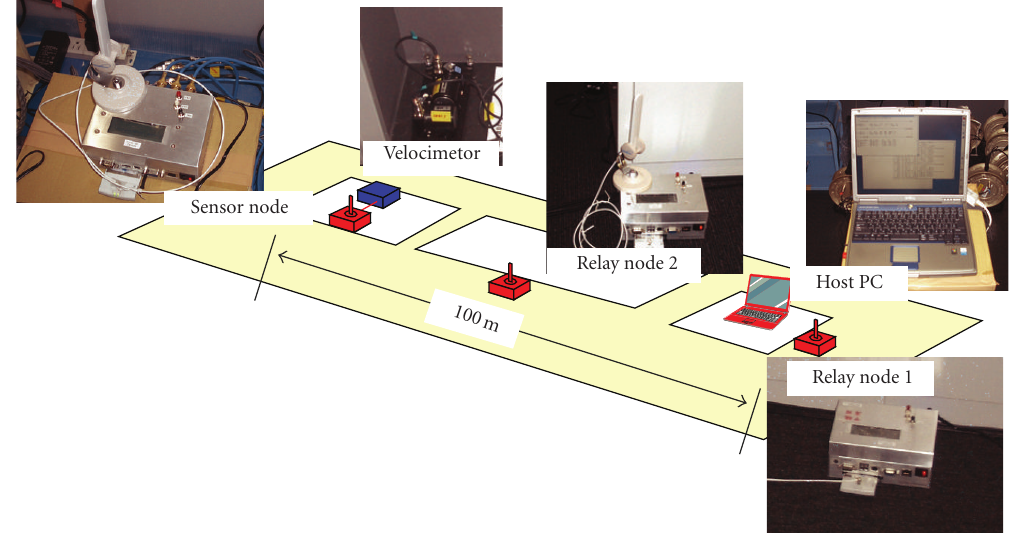
Figure 13: Allocation and photos of sensor node, relay node and Host PC.